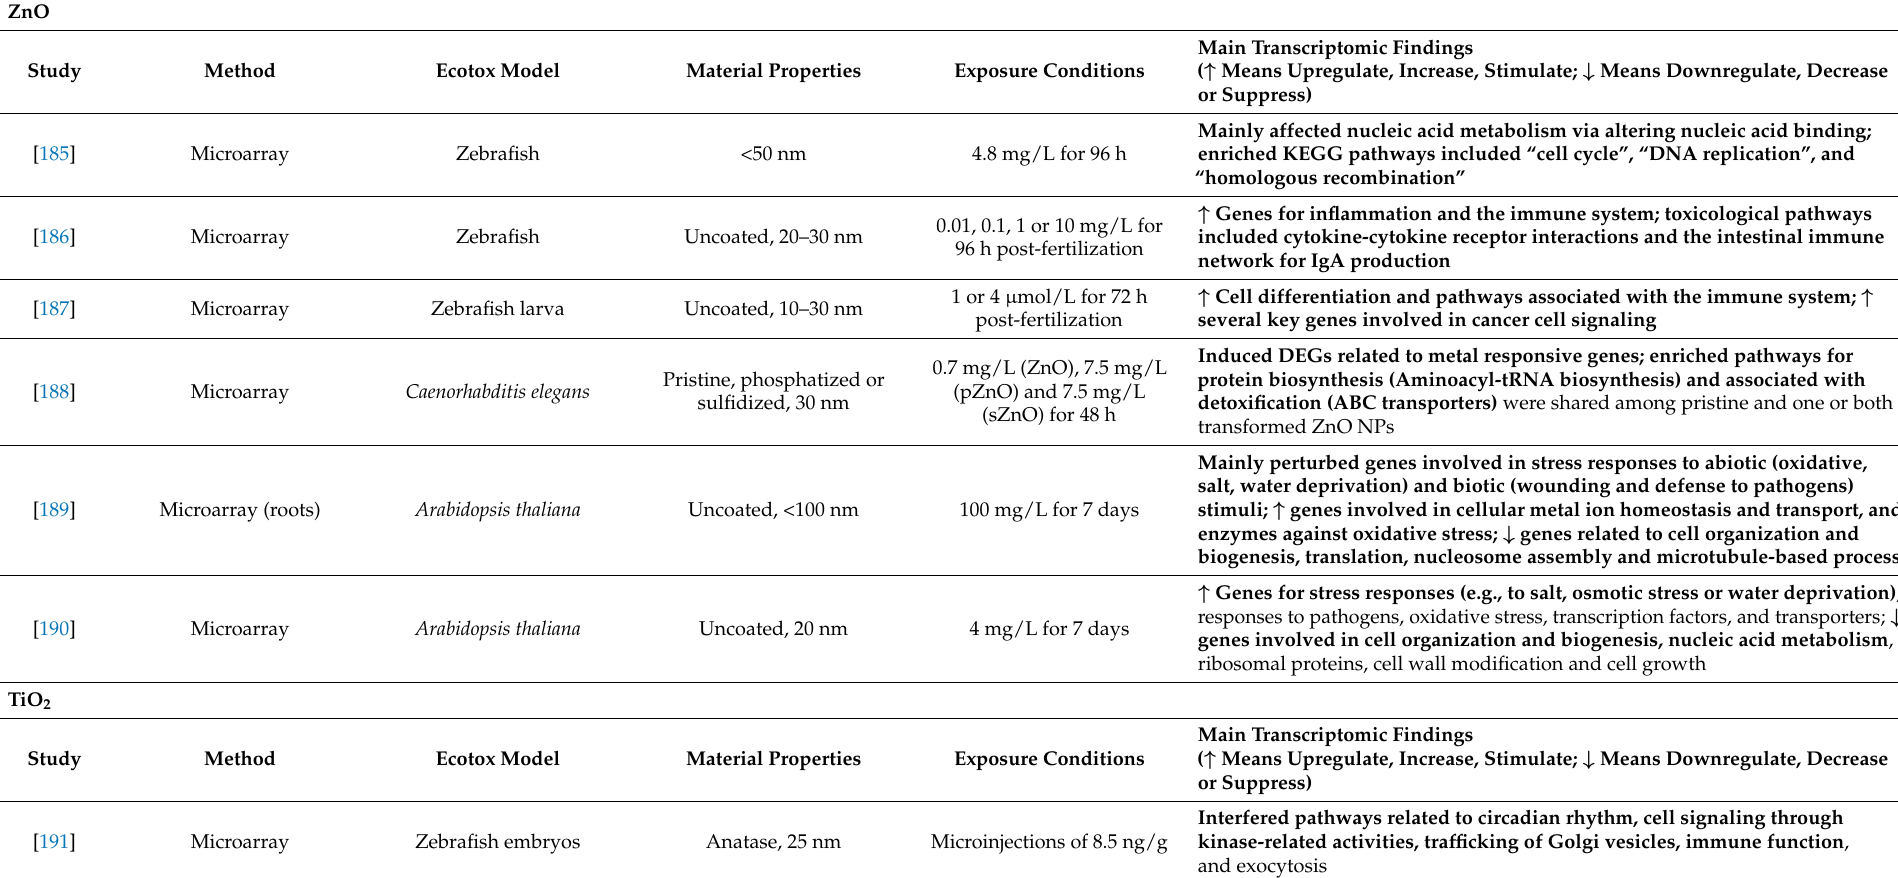
Table 3. Transcriptomic characterization of exposures to ZnO and TiO 2 NPs in ecotoxicology-related